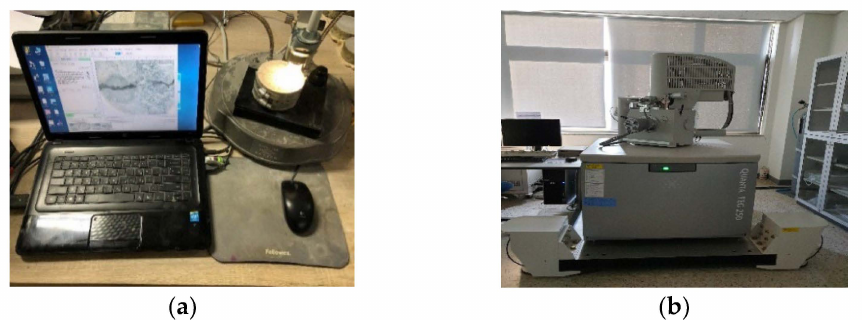
Figure 7. Healing product observation methods: ( a ) microscope and ( b )